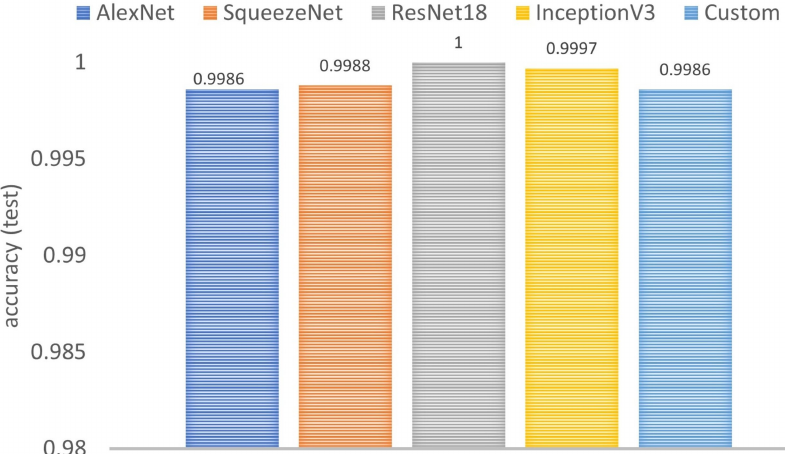
Figure 18. Comparison of the custom model and the four TL-based models in terms of accuracy (the higher the